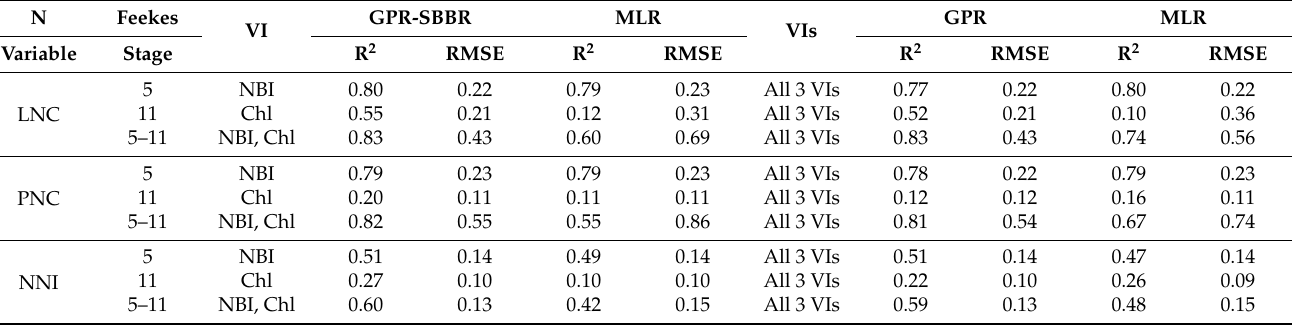
Table 11. Cross-validation results through GPR and MLR methods at different wheat growth